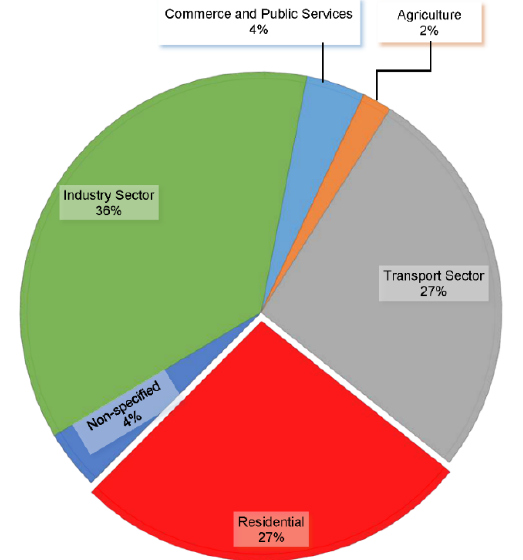
Figure 1. Sector-wise energy demand distribution in South Africa. Reprinted with the permission from ref. [16].